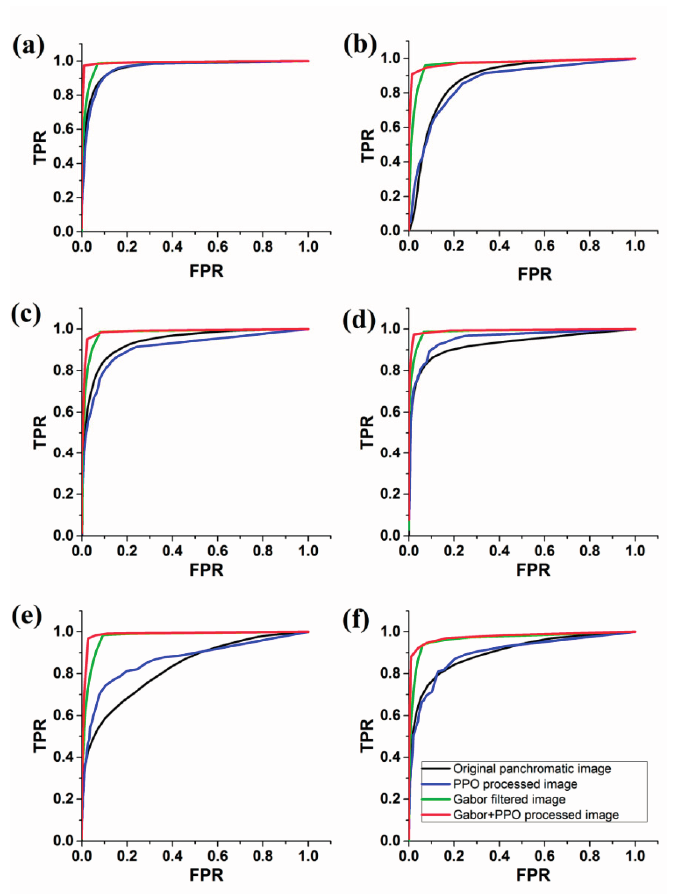
Figure 12. ROC graphs (TPRs against FPRs) of the river detection results when different global thresholds are applied to the original panchromatic image, the PPO-processed image, the Gabor-filtered image, and the Gabor + PPO processed (the proposed method) image. The result for Sites 1–6 is depicted by the curves in ( a )–( f ),